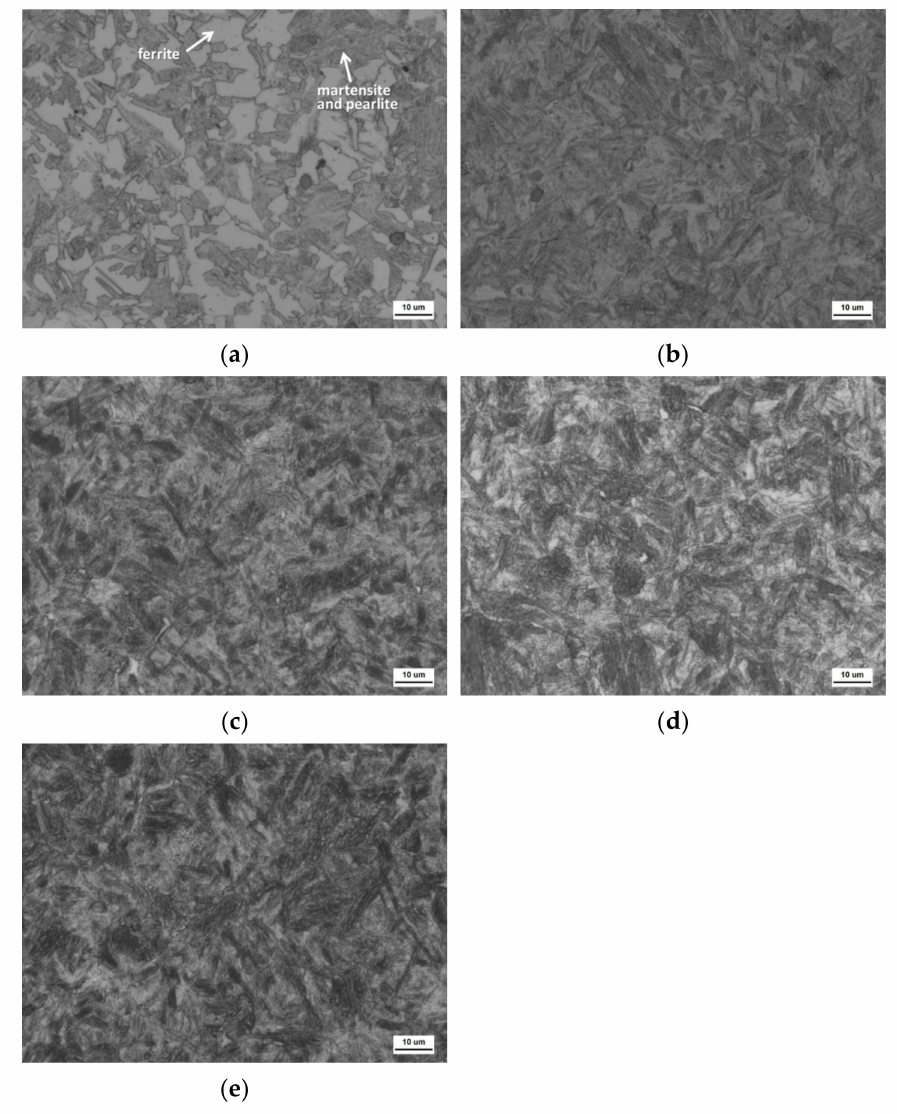
Figure 5. Optical micrographs showing the microstructure in the core matrix of the specimens austenitized at ( a ) 820 ◦ C, ( b ) 840 ◦ C, ( c ) 860 ◦ C, ( d ) 880 ◦ C, and ( e ) 900 ◦